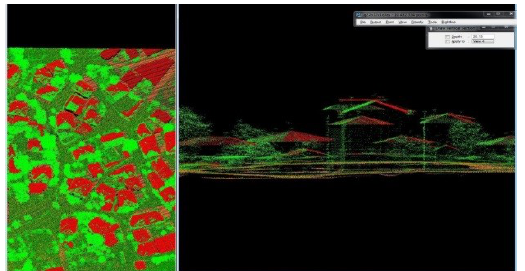
Figure 4: Situation of misclassification